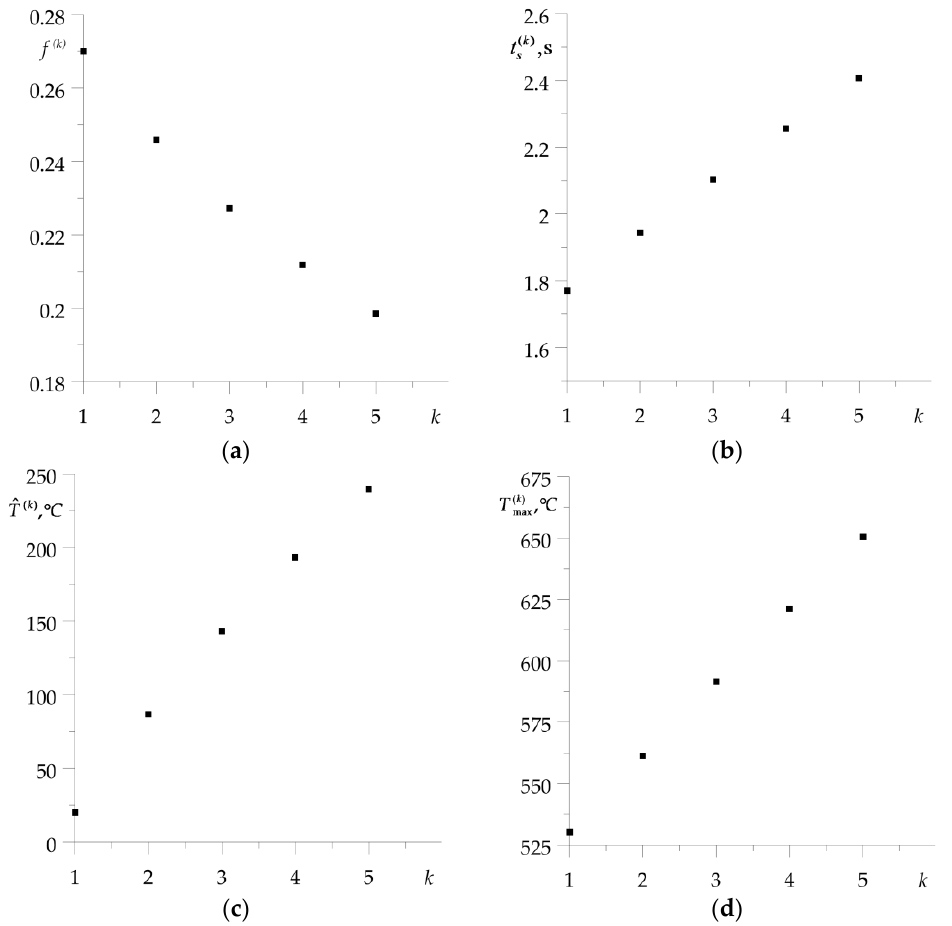
Figure 5. Dependencies on the number of braking applications k of: ( a ) friction coefficient f ( k ) (21); ( k ) ( b ) braking time t s (2); ( c ) volume temperature ( k ) surface T max .